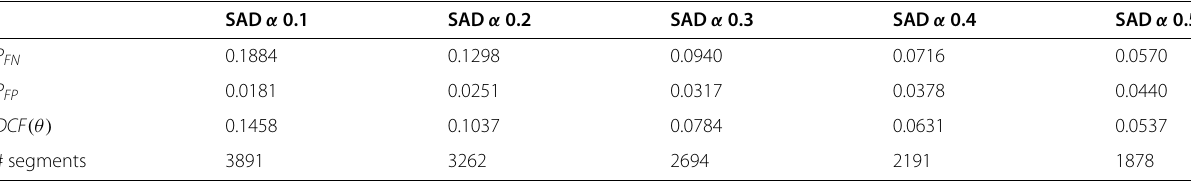
Table 5 SAD performance on different α